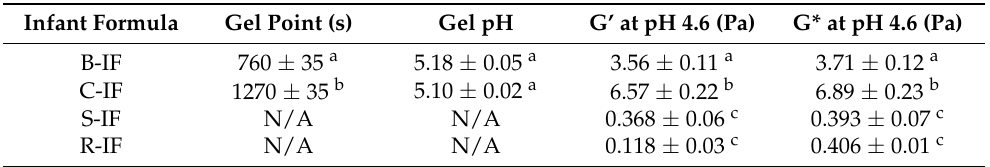
Table 3. Acid coagulation properties of infant formula (IF) samples treated with 2% ( w / v ) GDL at 30 ◦ C. Data presented as mean of three independent replicates ± standard deviation. B-IF (bovine IF), C-IF (caprine IF), S-IF (soy IF), and R-IF (rice IF). Infant Formula Gel Point (s) Gel pH G’ at pH 4.6 (Pa) G* at pH 4.6 (Pa) B-IF 760 ± 35 a 5.18 ± 0.05 a 3.56 ± 0.11 a 3.71 ± 0.12 a C-IF 1270 ± 35 b 5.10 ± 0.02 a S-IF N/A N/A 0.368 ± 0.06 c 0.393 ± 0.07 c R-IF N/A N/A 0.118 ± 0.03 c 0.406 ± 0.01 c * N/A = Not applicable. Different superscript letters within a column indicate statistical significance ( p < 0.05).